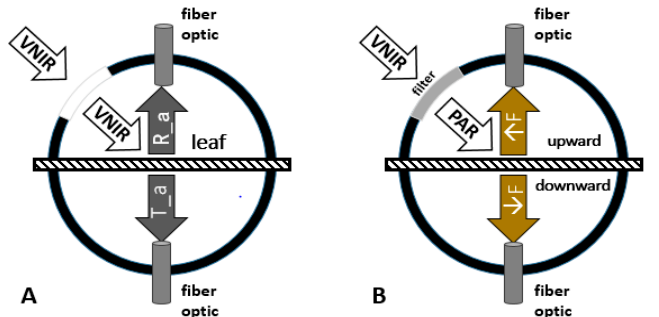
Figure 1. Scheme of the FluoWat leaf clip during measurement. Reflectance and transmittance with the contribution of SIF are measured by inserting a fiber into the upward and downward position of the FluoWat leaf clip ( A ); with the short-pass filter (wavelength shorter than 650 nm), the upward and downward SIF are collected ( B